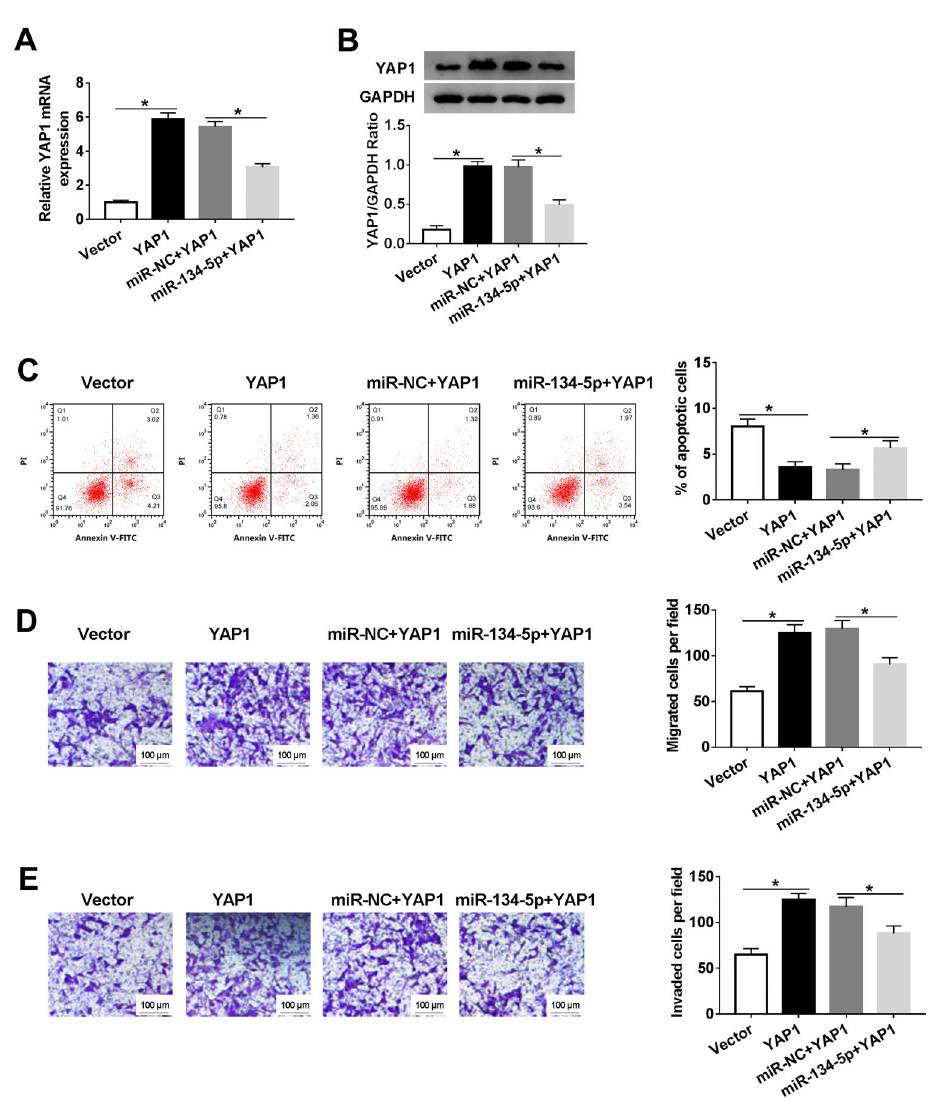
Figure 6. A – E , HTR8/SVneo cells were transfected with Vector, YAP1, miR-NC (negative control) + YAP1, or miR-134-5p + YAP1. A , The level of YAP1 was detected by qRT-PCR. B , The protein level of YAP1 was examined via western blot. C , The apoptotic rate was assessed through fl ow cytometry. D and E , The migrated and invaded cells per fi eld were calculated by Transwell assay (scale bar 100 m m). Data are reported as means ± SD. *P o 0.05